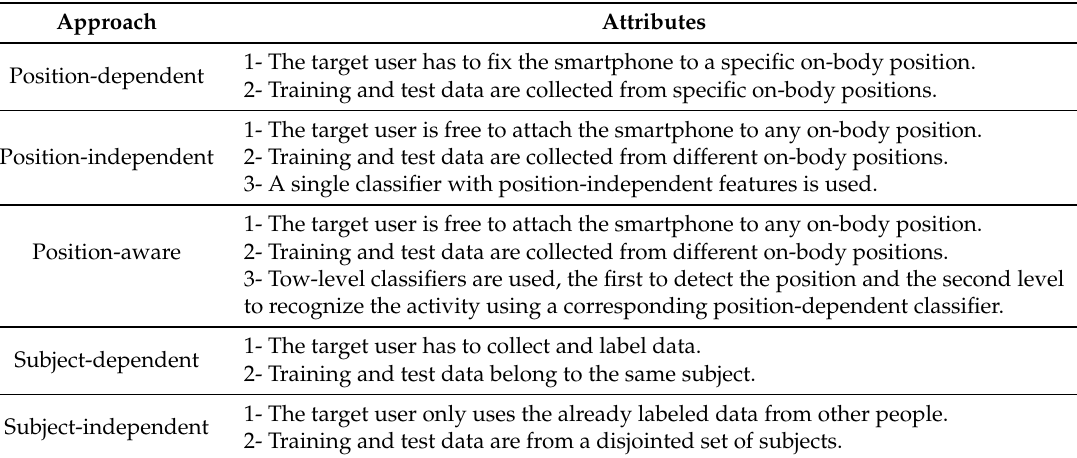
Table 4. List of evaluation scenarios often used in the literature.